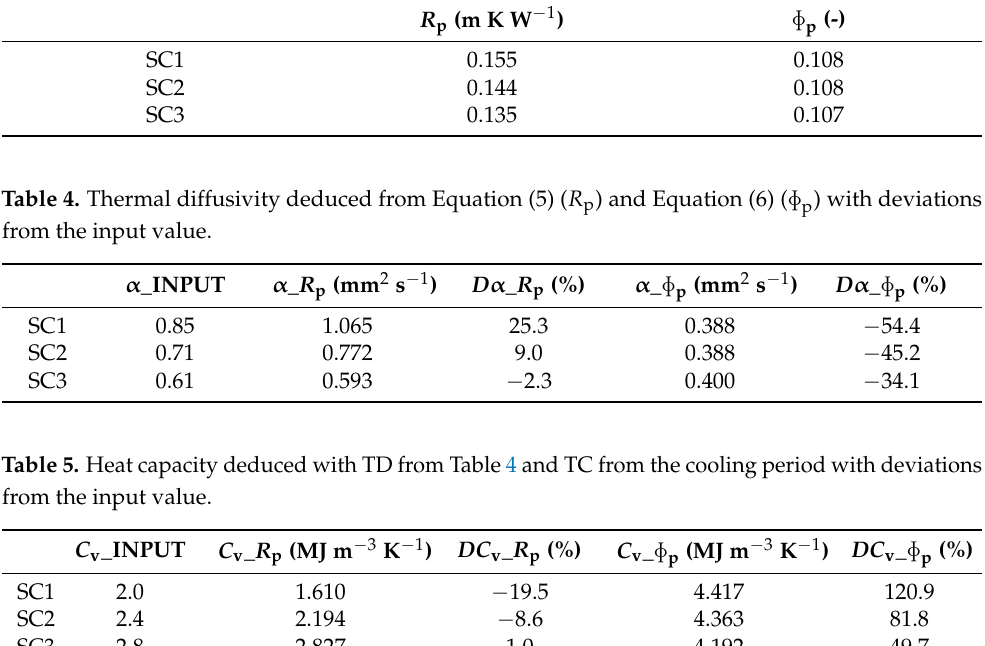
Table 3. OTRT parameters inferred from the numerical simulations.